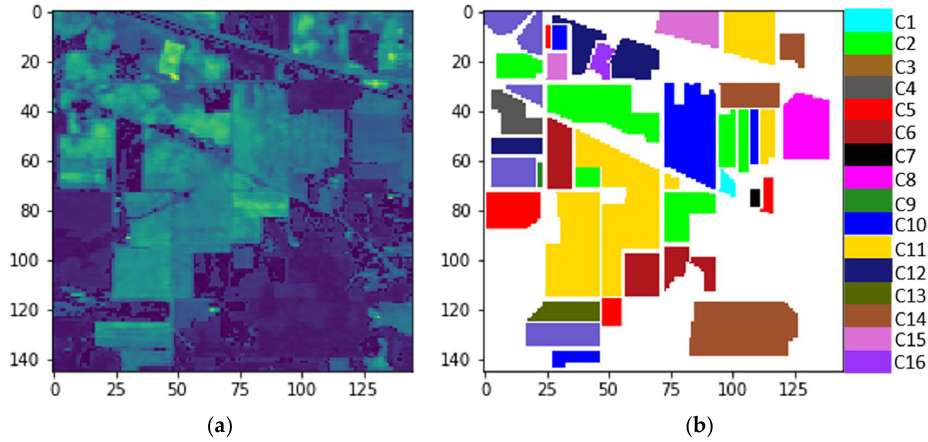
Figure 3. The Indian Pines image: ( a ) the 21th band image; ( b ) the ground truth of Indian Pines, where the white area represents the unlabeled pixels. Table 1. Indian Pines image: the number of samples per class.